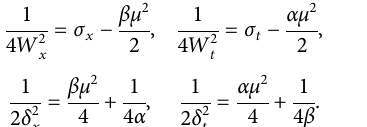
Δ v x = 0.0645 cm